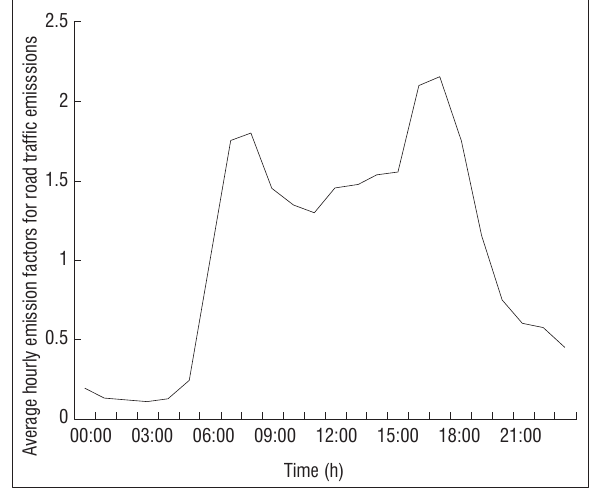
Figure 2: Diurnal variation of traffic emissions based on factor estimation (adopted from Menut et al. 28 ). NMHC (non-methane hydrocarbon) emissions (ton/year) based on the mass fraction (adopted from Derwent et al. 24 ) Species